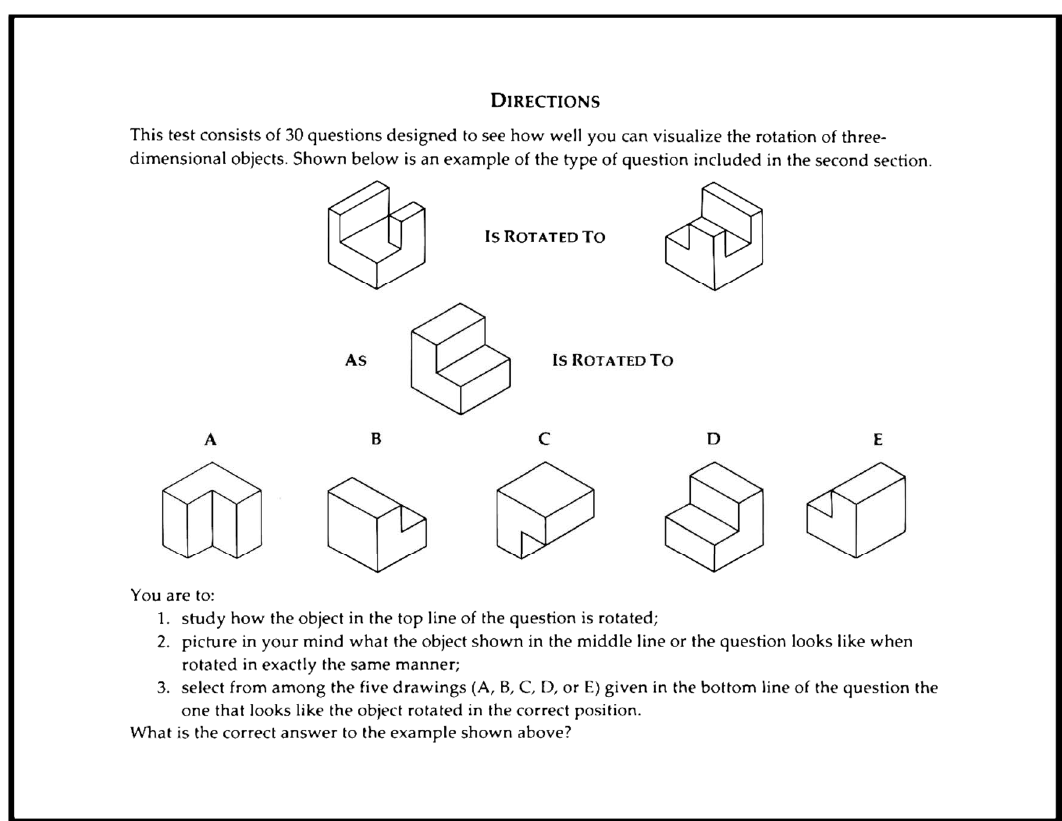
Figure 8 . Revised Purdue spatial visualization test. Figure 8. Revised Purdue spatial visualization